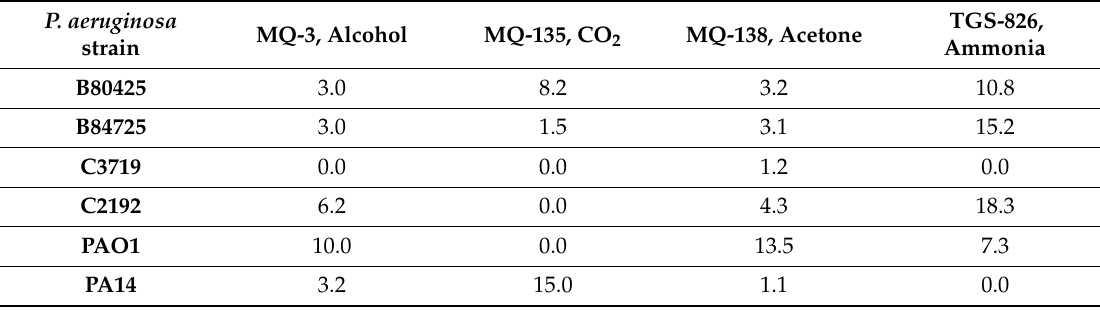
Table A5. Mean values of the P. aeruginosa liquid samples at 5 mm.